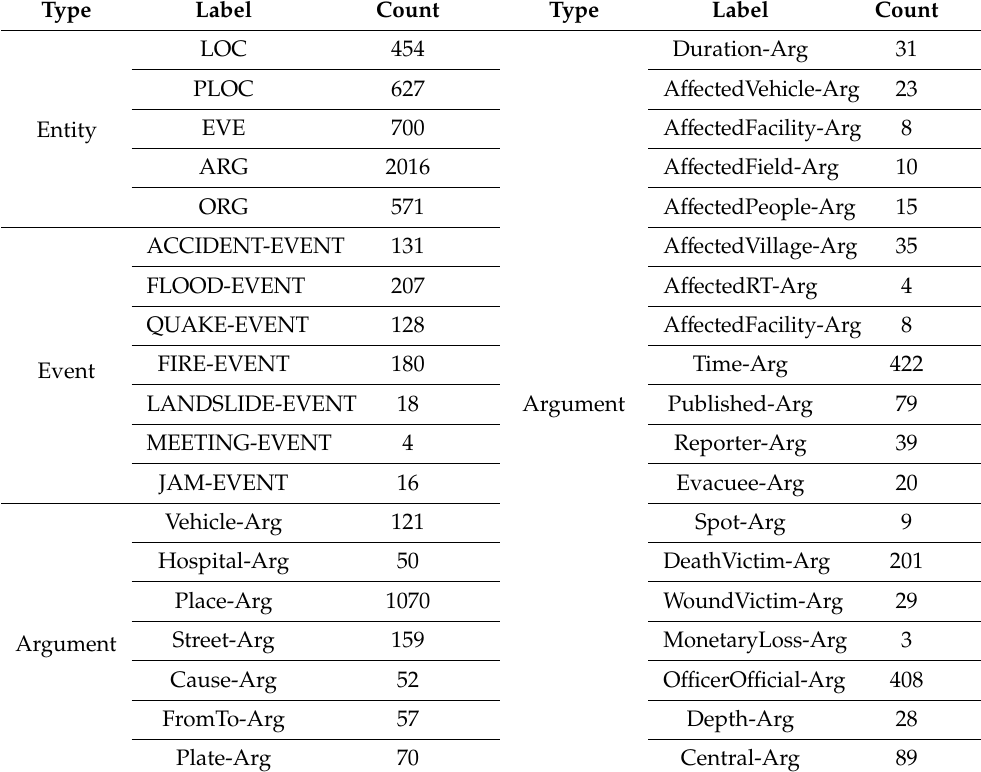
Table 3. Label statistics within Event Geoparsing Indonesian News Dataset. For brevity, the B- and I- prefix variation for each tag are collapsed into one label